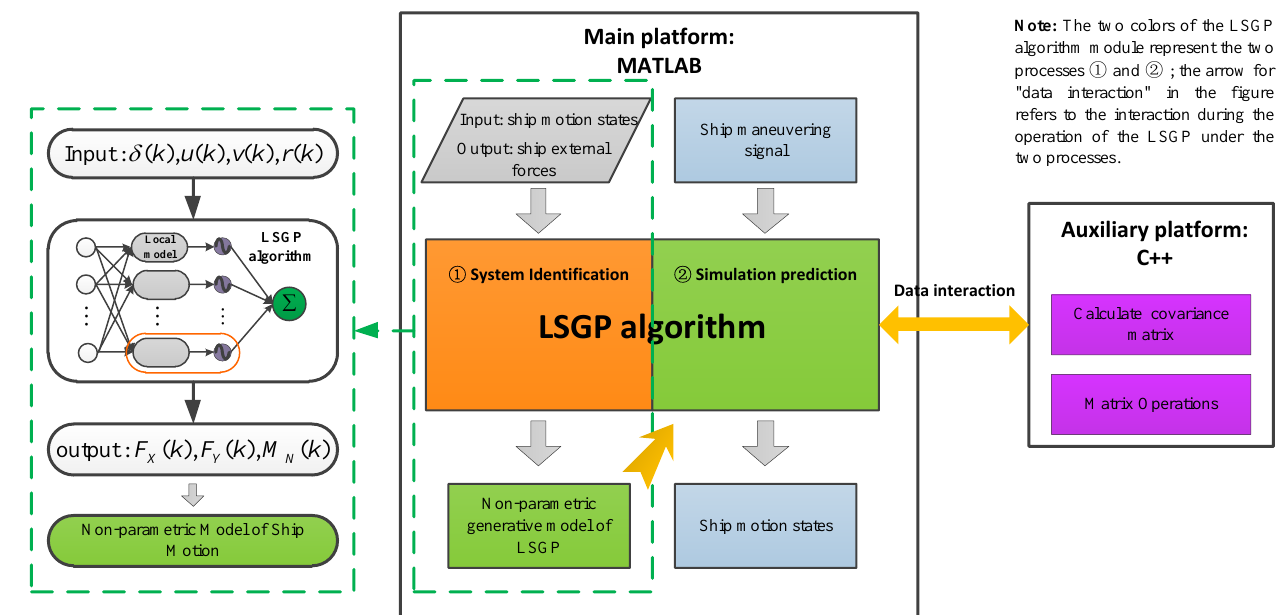
Figure 3. Structural modules for identification and modeling of ship maneuvering motion based on